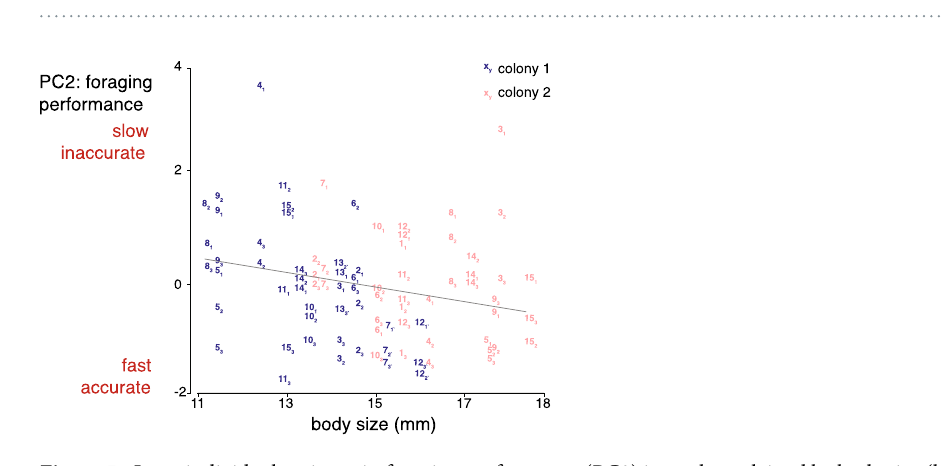
Figure 4. Intra- and inter-individual behavioural variance across experimental arrays. ( a ) Route fidelity (PC1). ( b ) Foraging performance (PC2). Data points connected by a dashed-line represent the scores of the same individual over the three arrays. Blue: colony 1 (N = 15 bees), red: colony 2 (N = 14 bees). Numbers refer to individual bees (the same number code was used in Figs 3 and 5).